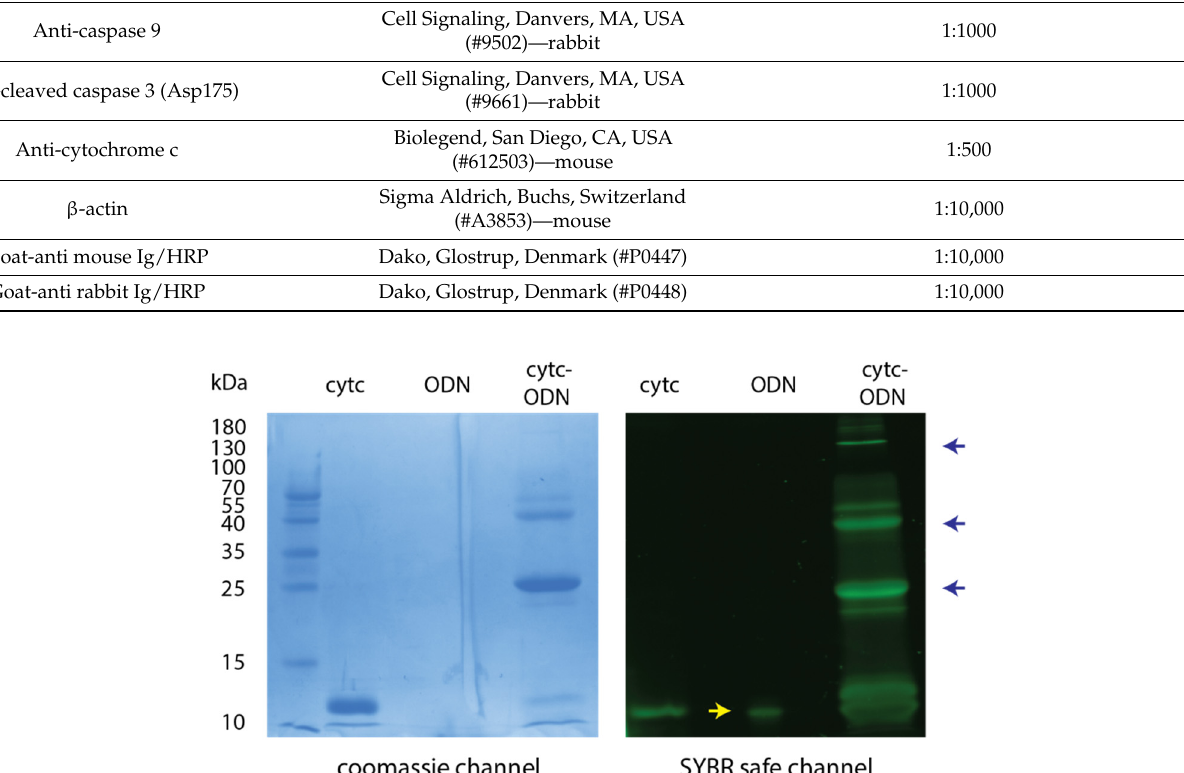
Figure A1. SDS-PAGE analysis of the DNA-protein conjugates. Samples were run in 12% PAGE gel under reducing conditions and stained with Coomassie blue for cytochrome c detection and SYBR safe for DNA detection. Oligonucleotide-conjugated cytochrome c was seen in both Coomassie and SYBR safe stainings, whereas oligonucleotides were detected by SYBR safe staining only (highlighted by arrows).